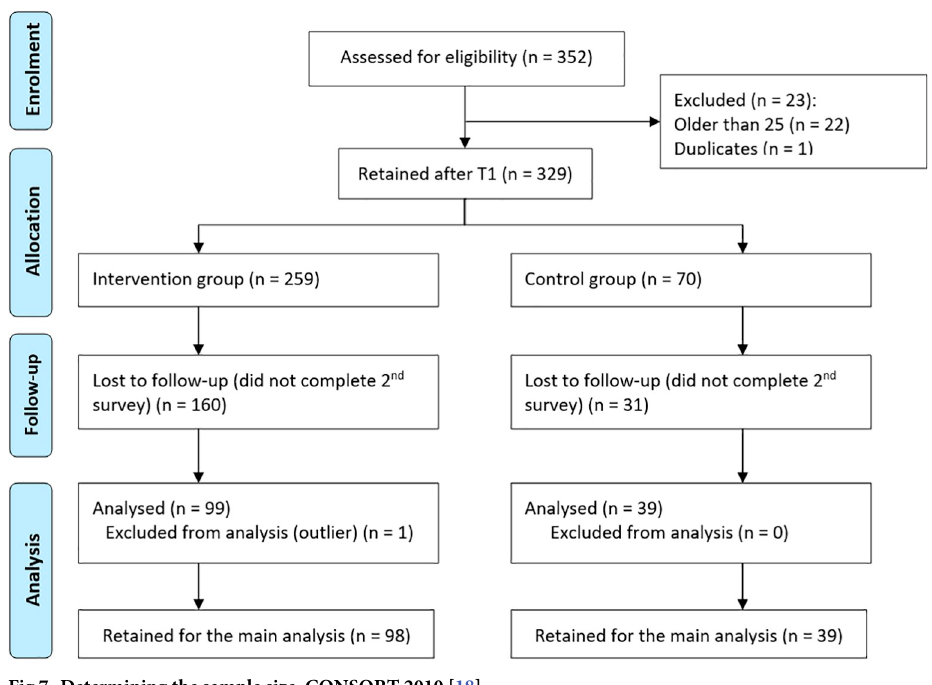
Fig 7. Determining the sample size, CONSORT 2010 [18].